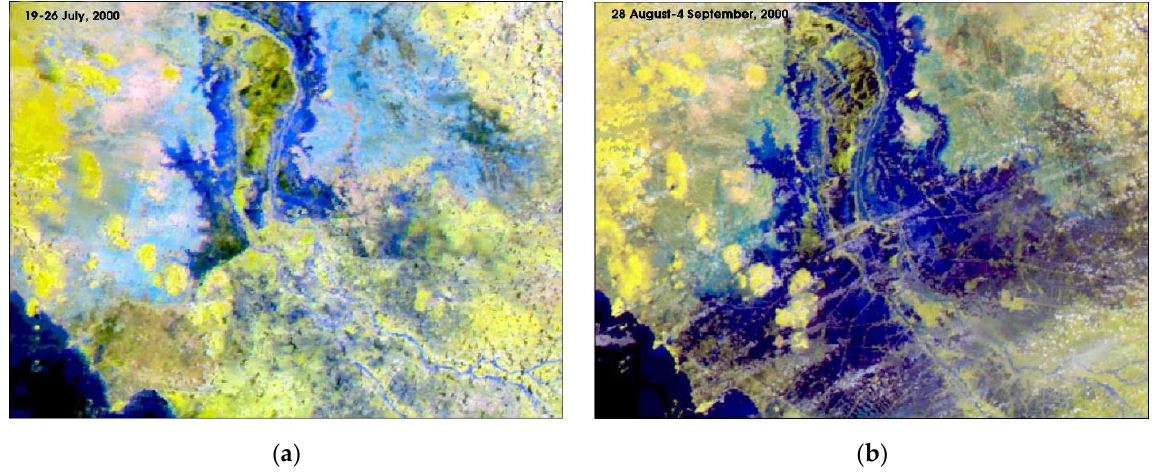
Figure 6. Landsat satellite image of the historic flood in 2000 in most parts of the VMD. The flood by mid-end July 2000 ( a ); and the flood in early September 2000 ( b ). Source: Landsat images were free-downloaded from the United States Geological Survey (USGS) (https://earthexplorer.usgs.gov/, accessed on 9 January 2022).